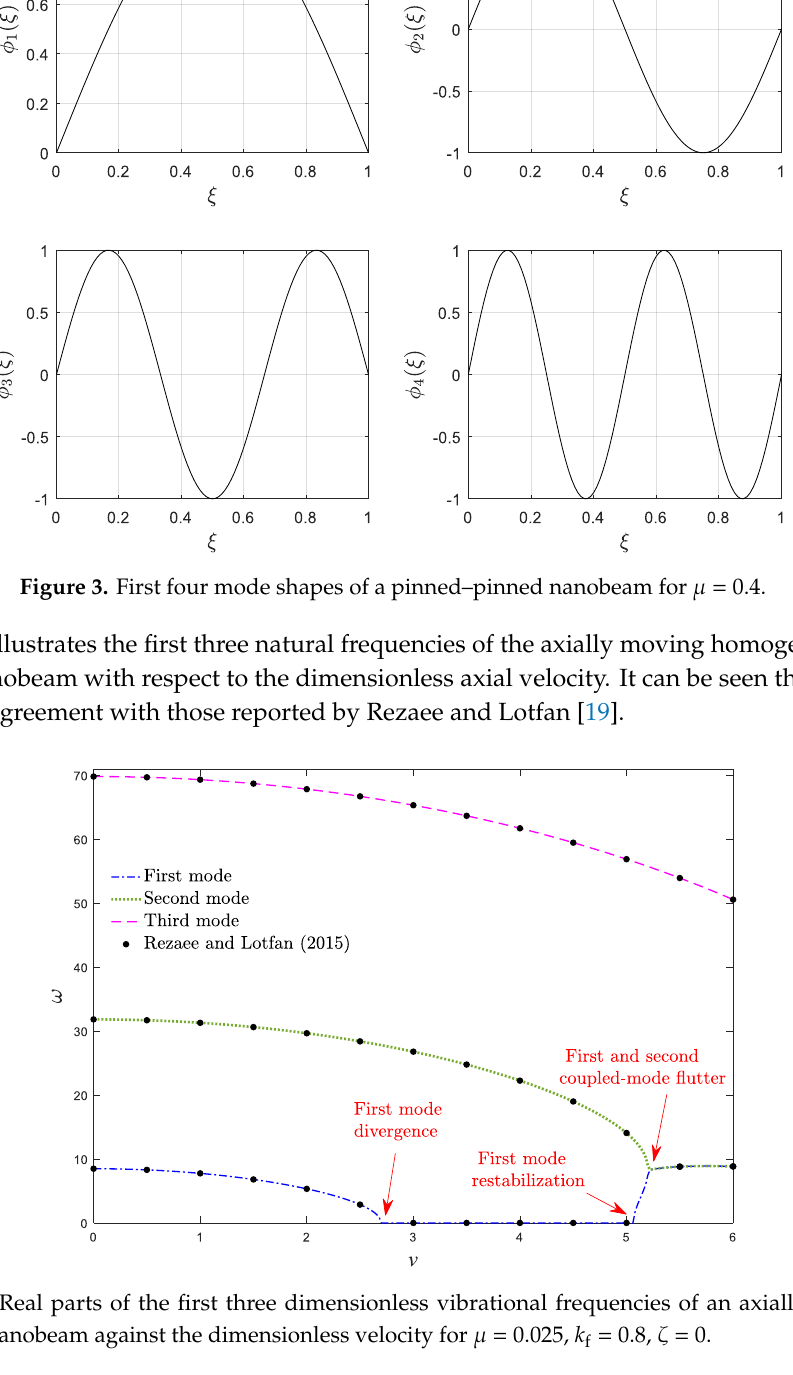
Figure 2. Variations of fifteen eigenvalues of a pinned–pinned nanobeam against nonlocal parameter.